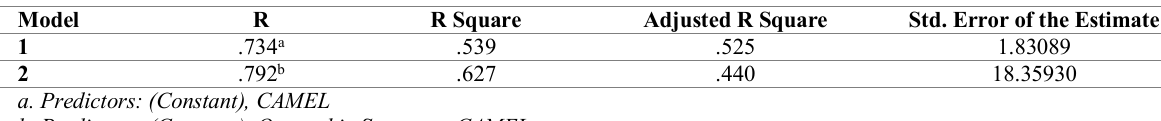
Table 10: Composite Moderating Effect of Ownership